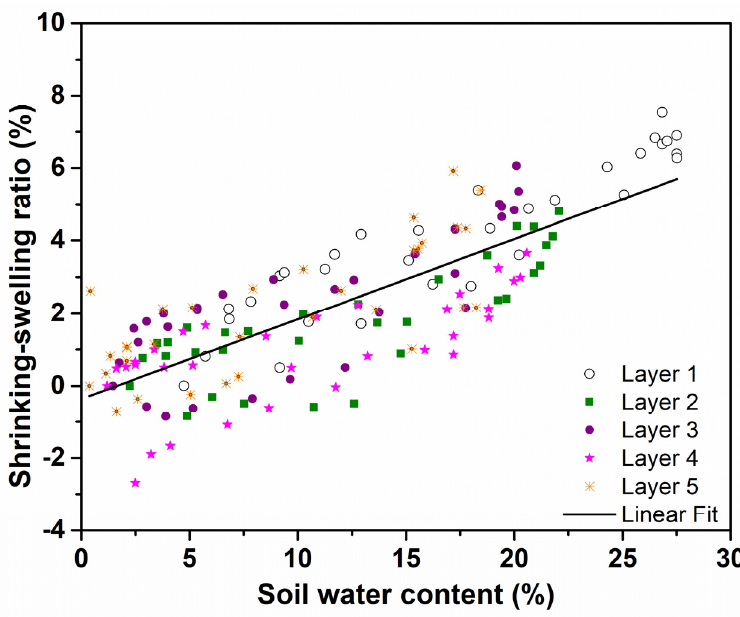
Figure 5. The relationship between shrink–swell ratio and soil water